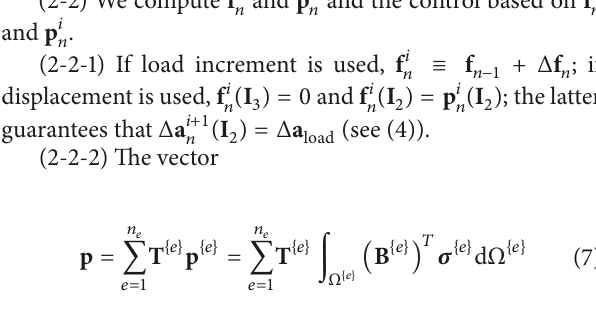
Figure 1: Geometry, meshing, and illustration of stress-strain relation of Model